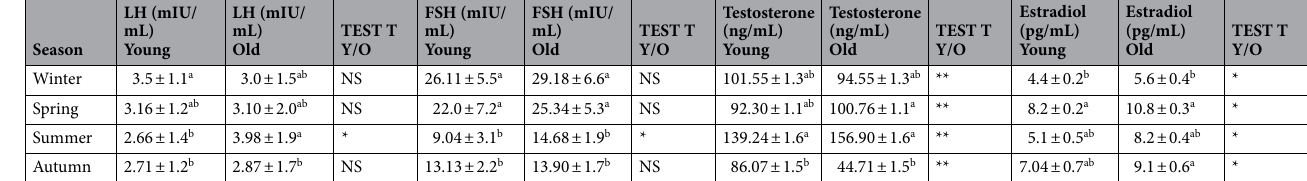
Table 6. Concentration of hormones in the blood serum of younger and older bulls in relation to different season (mean ± SD). Explanation: Values with different letters (a, b) differ significantly between rows P <